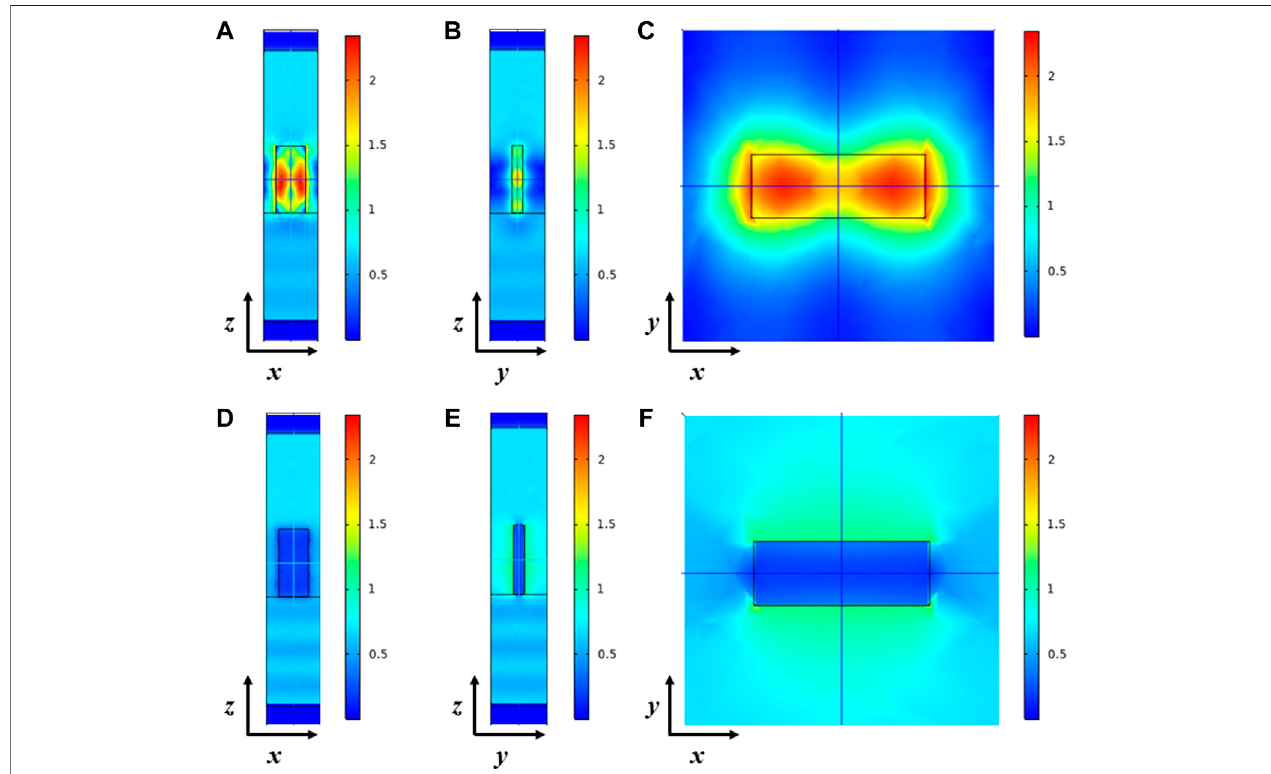
FIGURE 2 | Example of FEM simulations of a metaatom ( U x (cid:2) U y (cid:2) 400nm) composed by a silicon nanopillar ( L (cid:2) 220nm, W (cid:2) 80nm and H (cid:2) 500nm, i.e. , pillar #11 in Figure 3 ) on a glass substrate under TE (A – C) and TM (D,E) polarization in input from the air side. Lateral cross-sections at y = 0 (A,D) and x = 0 (B,E) and top- view cross-section at z = H /2 (C,F) . Input wavelength 775 nm. Colours refer to the intensity of the electric fi eld (a.u.).